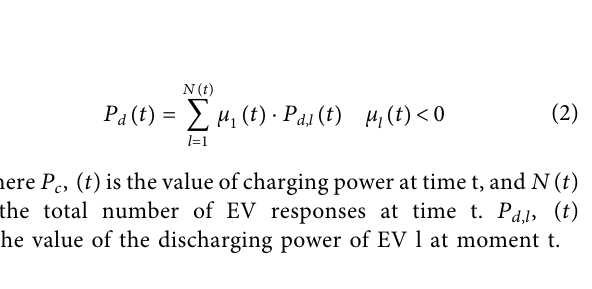
FIGURE 2 | Framework for distributed energy systems factors in fl uencing the load capacity of